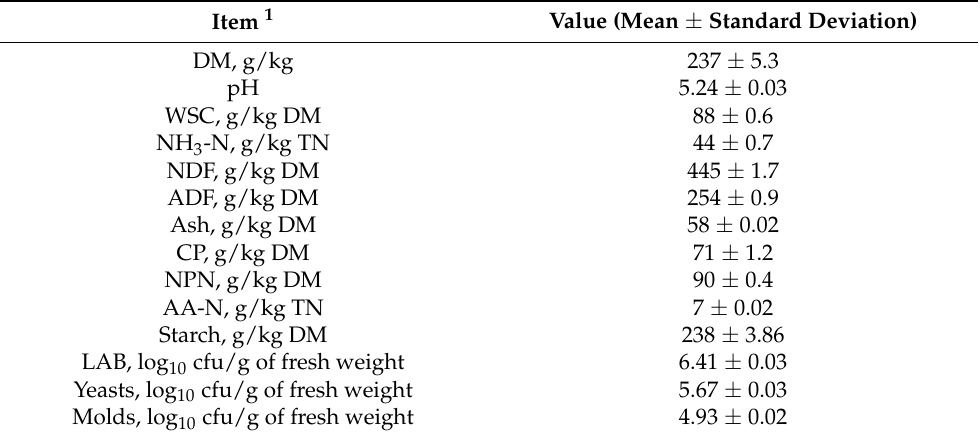
concentration was observed in the L. buchneri 9-2 inoculated silage. The NDF and ADF in the control silage were higher ( p < 0.05) than L. buchneri inoculated silages; however, there was no difference ( p > 0.1) among the inoculated silages. Table 3. Chemical composition and microbial populations of fresh whole-plant corn prior to ensiling.